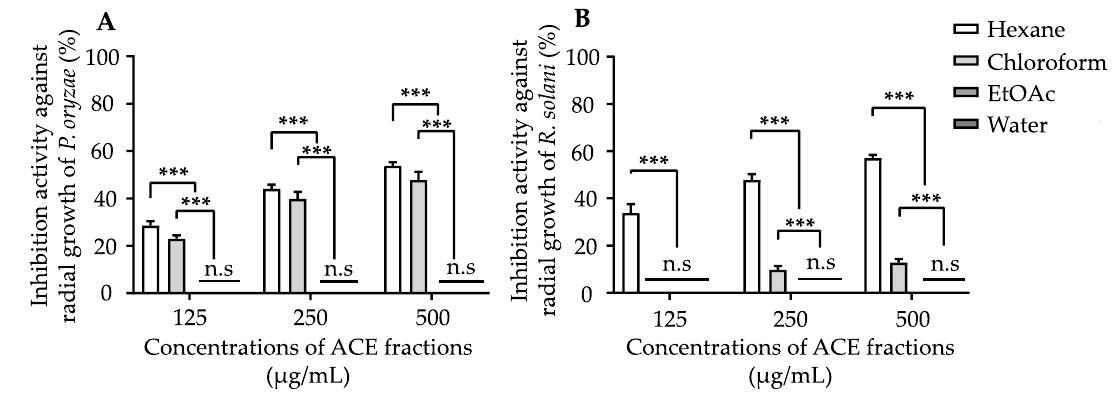
Figure 2. Antifungal activities of ACE fractions obtained via solvent partition. Four fractions, ACE-hexane, ACE-chloroform, ACE-EtOAc, and ACE-water, were assayed for their antifungal activities against P. oryzae ( A ) and R. solani ( B ) using the poisoned food assay. After culturing P. oryzae for 14 days or R. solani for 2 days, radial growth of fungi was measured and PI (%) was calculated. n = 5, n.s., no significant difference; data are presented as mean ± SD; ***, p < 0.001 .